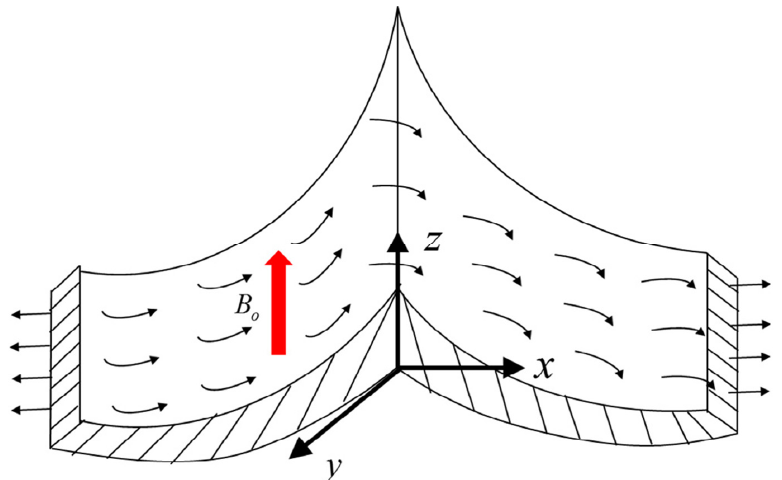
Figure 1. Exponentially stretching surface MHD